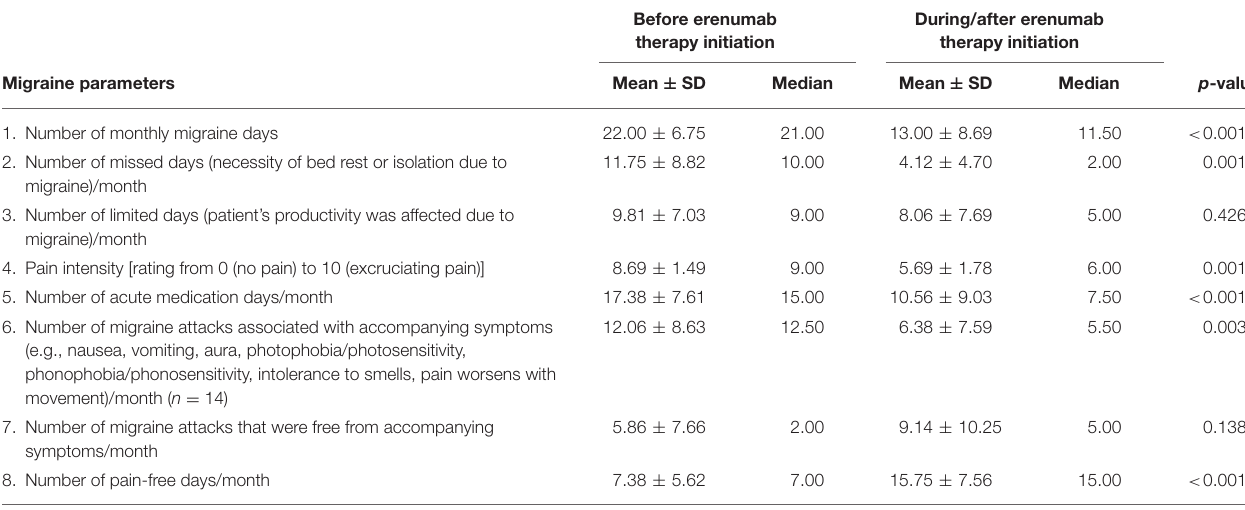
TABLE 3 | Migraine parameters before and after erenumab therapy.